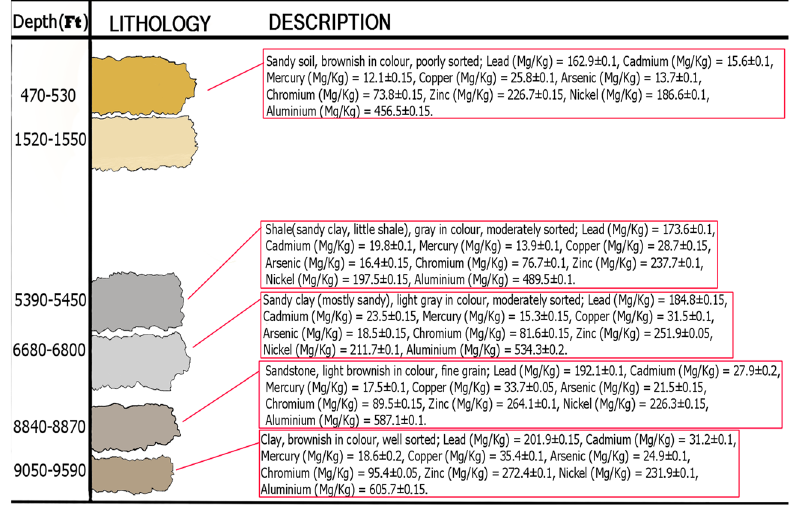
Figure 3. Heavy Metals distributions across the Subsurface Lithofacies